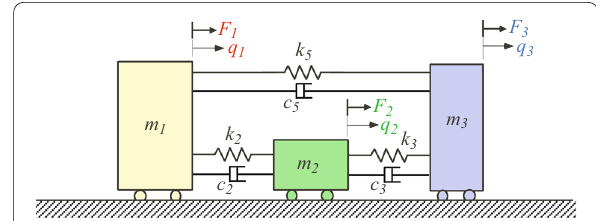
Fig. 2 Unconstrained and nonconservative 3-DoF mass-spring-damper